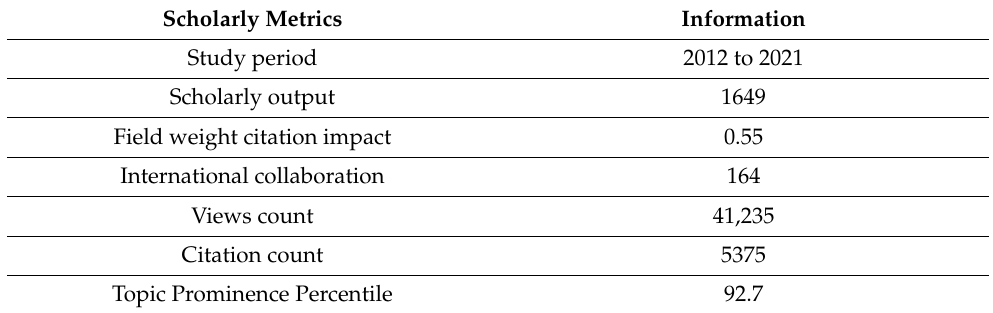
Table 2. Scholarly Characteristics. Scholarly Metrics Information Study period 2012 to 2021 Scholarly output 1649 Field weight citation impact 0.55 International